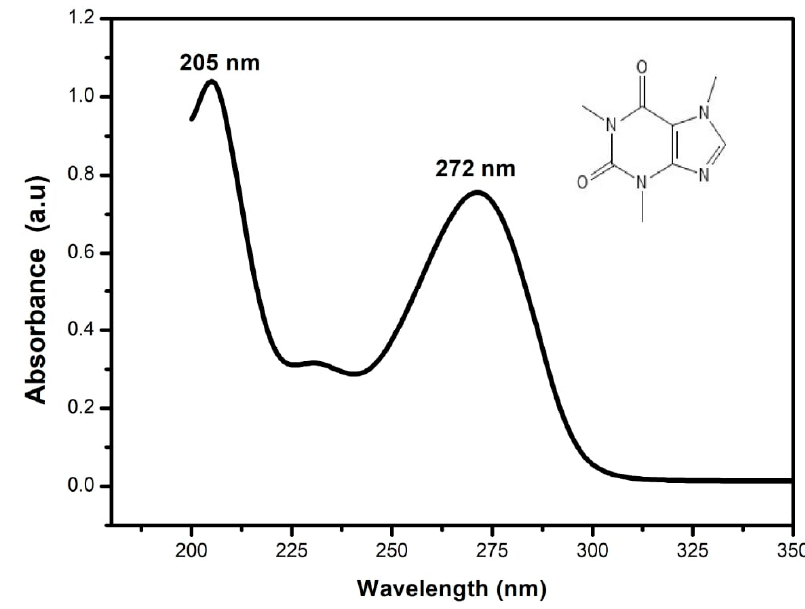
Figure 4. UV spectra of caffeine before photocatalytic degradation.